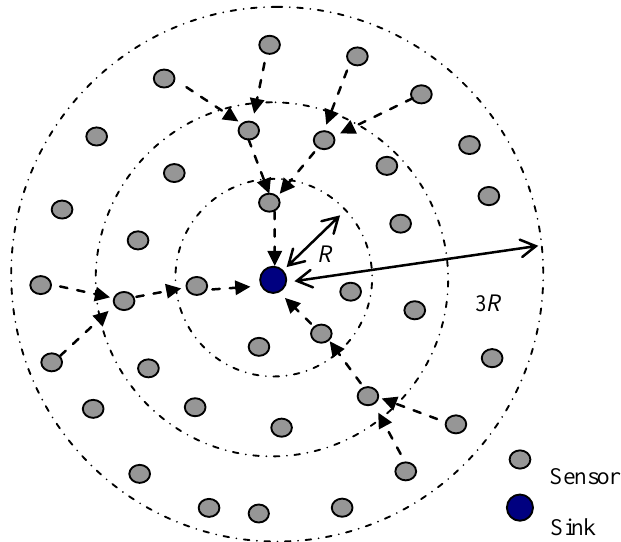
Figure 3. A network with uniformly distributed sensor